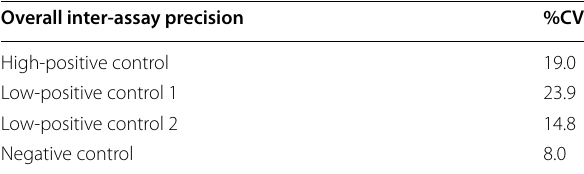
CP cut point, SD standard deviation a Regression model: 5PL (auto) with weighting factor of 1/F ^ 2 b Sensitivity was calculated using “average concentration